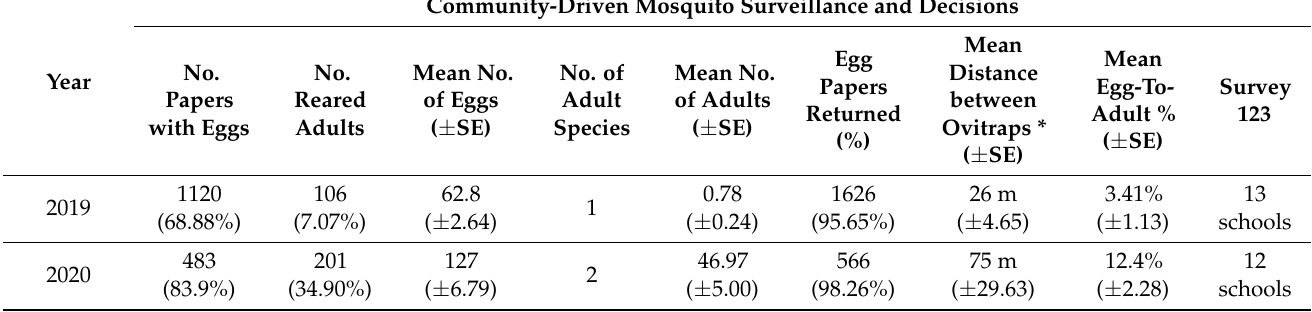
Table 2. Over two years, educators improved with their ability to lead the community-driven mosquito surveillance as indicated by increased adults and increased distance between